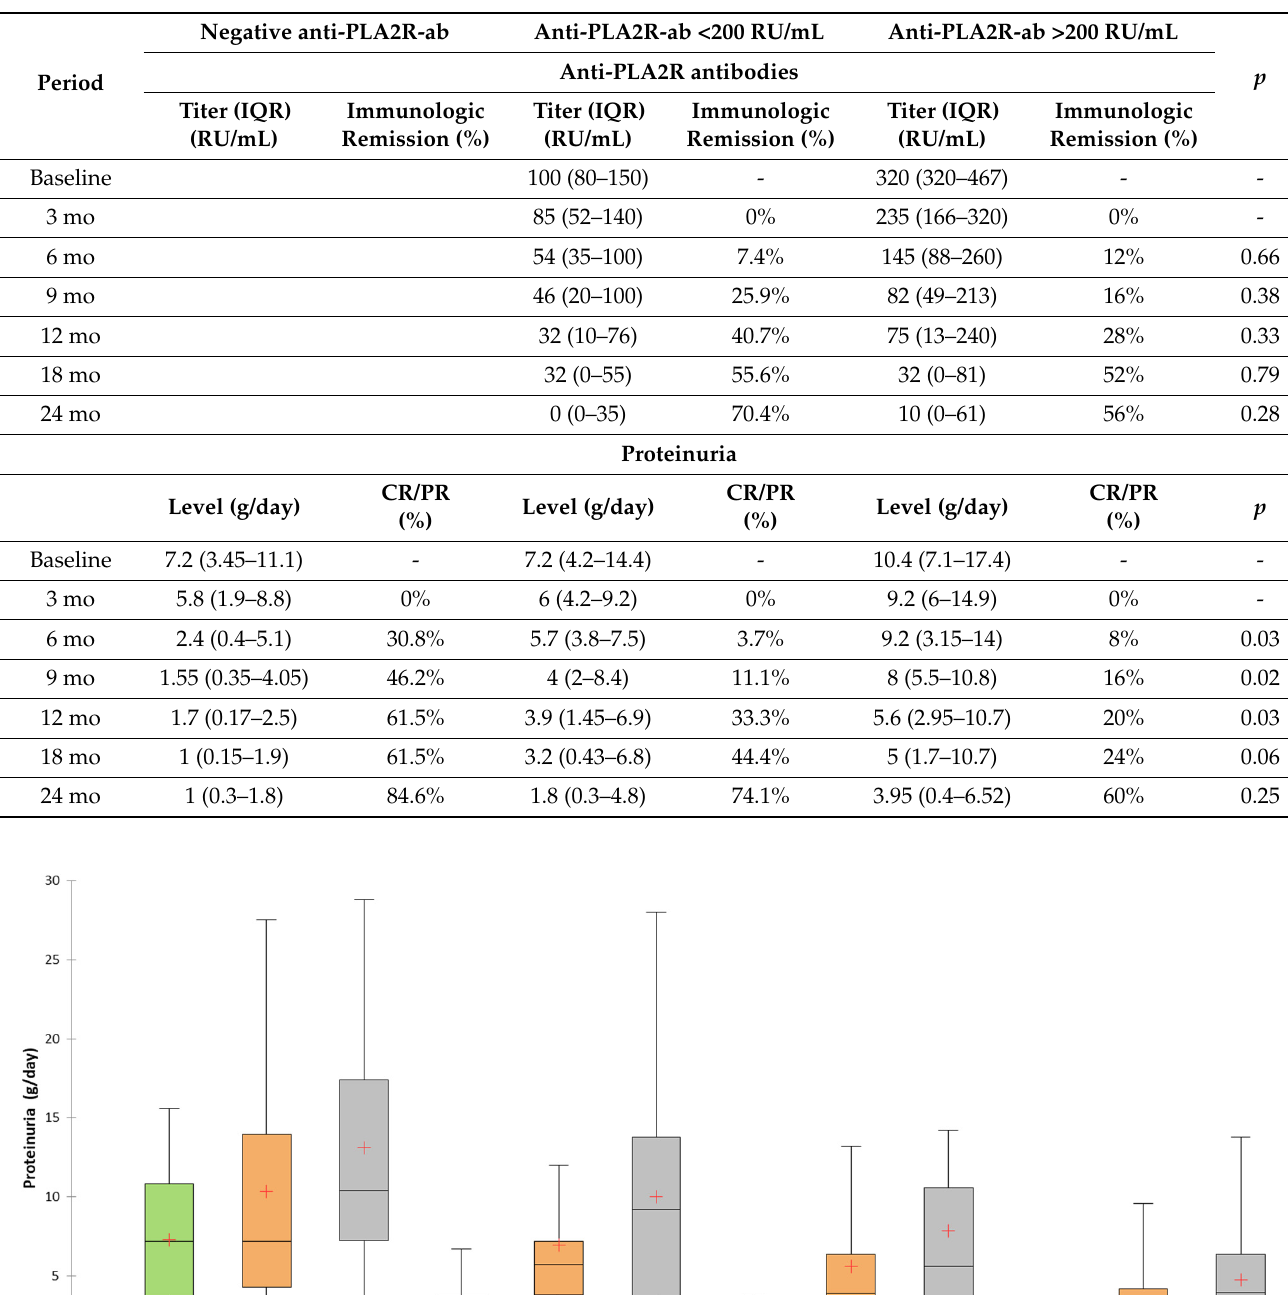
Table 2. Evolution of sPLA2R-ab titer and 24-h proteinuria according to baseline anti-PLA2R antibody status.